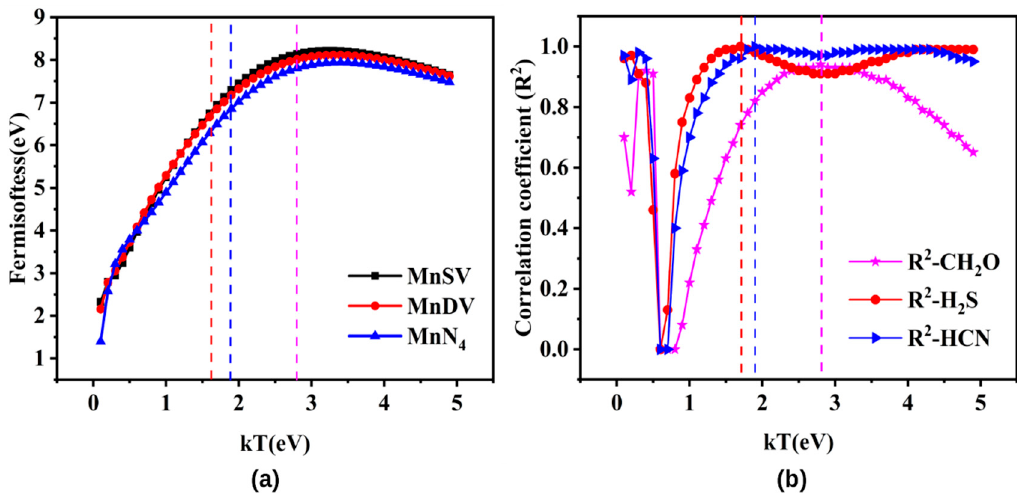
Figure 4. The effect of kT on ( a ) Fermi softness of MnX-GN and ( b ) the square correlation coefficient.